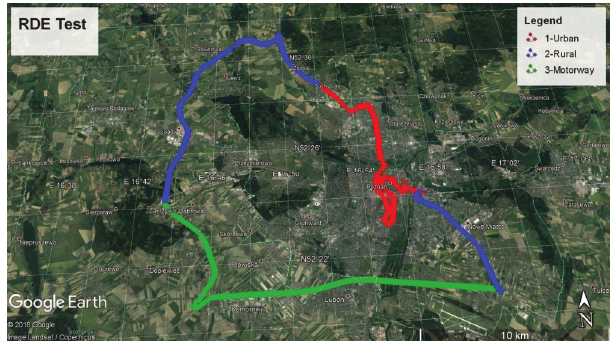
Fig. 2. The research route with marked RDE test phases